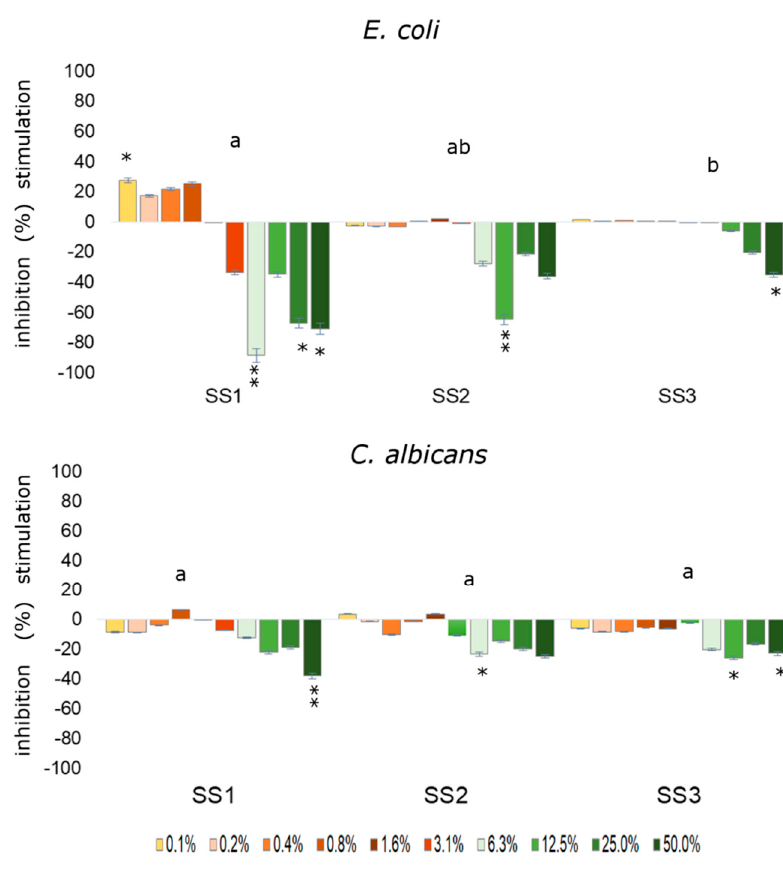
Figure 1. The growth stimulation / inhibition of E. coli and C. albicans exposed to three di ff erent types of SS filtrates (SS1, SS2, SS3) for 24 h calculated as a percentage of control. The same letters indicate insignificant di ff erences between SS filtrates for analyzed strains, assessed by Tukey’s test (p < 0.05). * p < 0.05, ** p < 0.01, *** p < 0.001 represent significant e ff ects between treatments and control followed by Dunnett’s test.